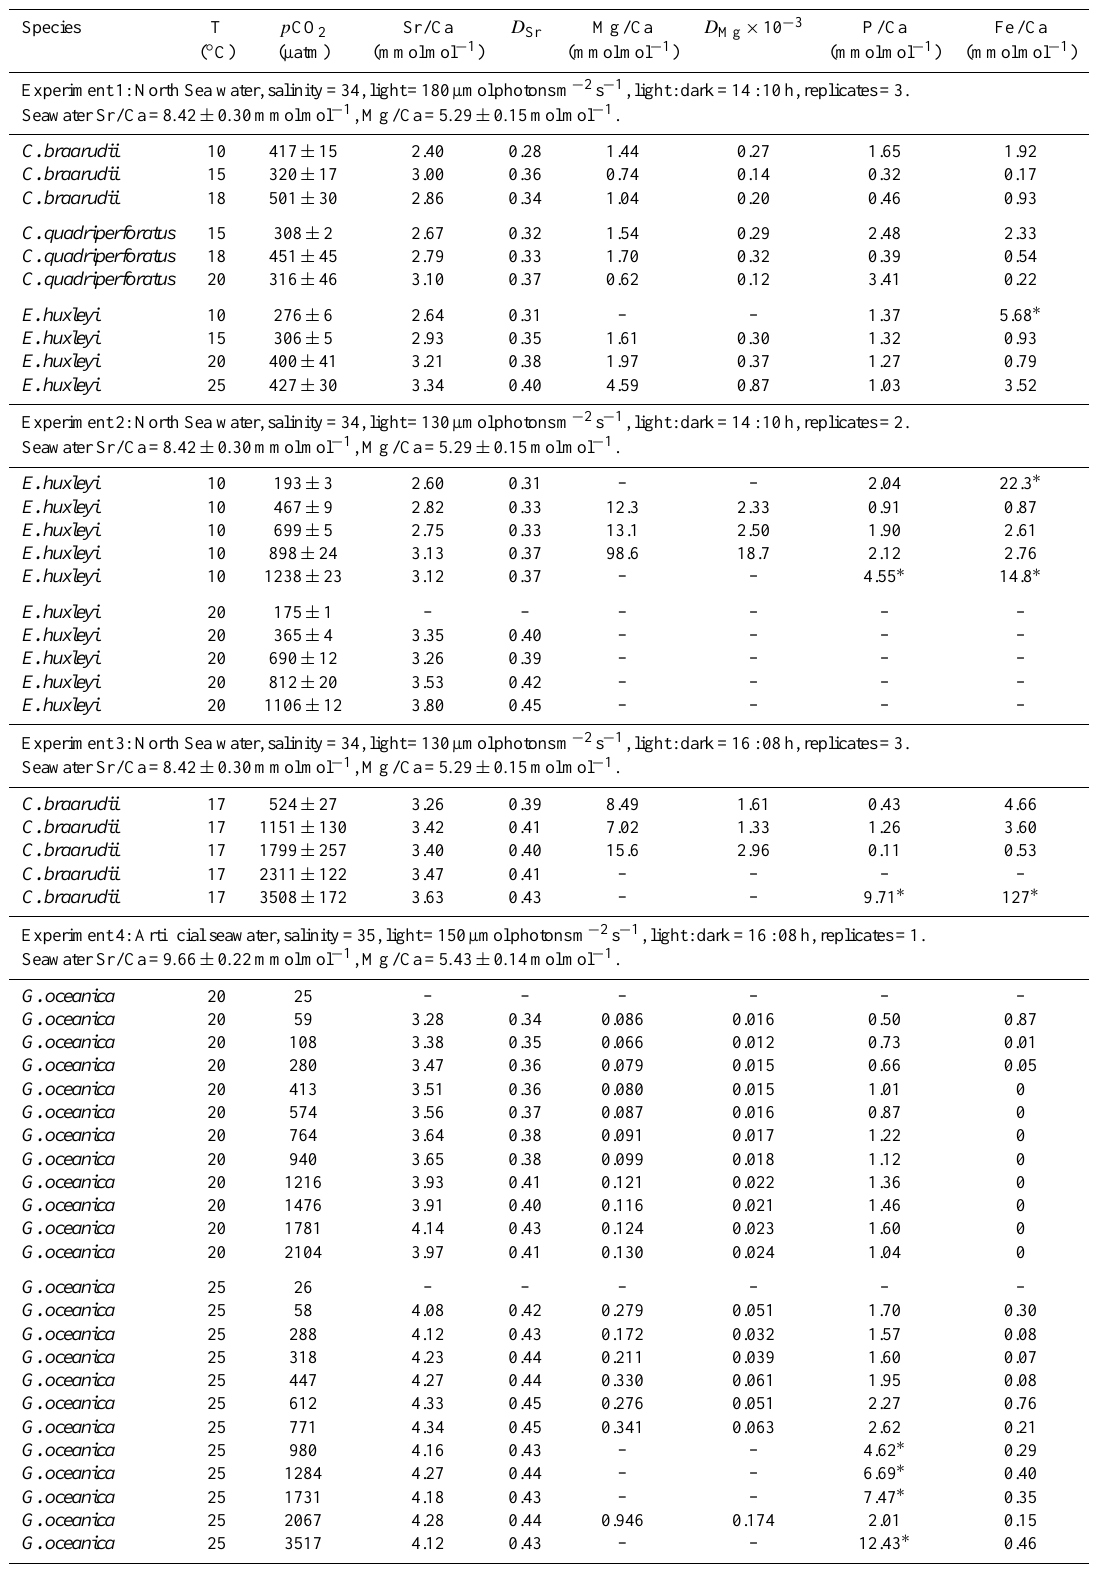
Table 1. Coccolith calcite chemistry of the four individual experiments with corresponding experimental conditions. P/Ca and Fe/Ca ratios (averages of 1 . 36 ± 0 . 73 and 0 . 82 ± 1 . 19, respectively) were used as an indicator for Mg cleaning efficiency. Detected outliers indicated non-sufficient Mg removal (indicated with ∗ ) and corresponding Mg/Ca ratios were removed from the data set. Species T p CO 2 Sr/Ca D Sr Mg/Ca D Mg × 10 −